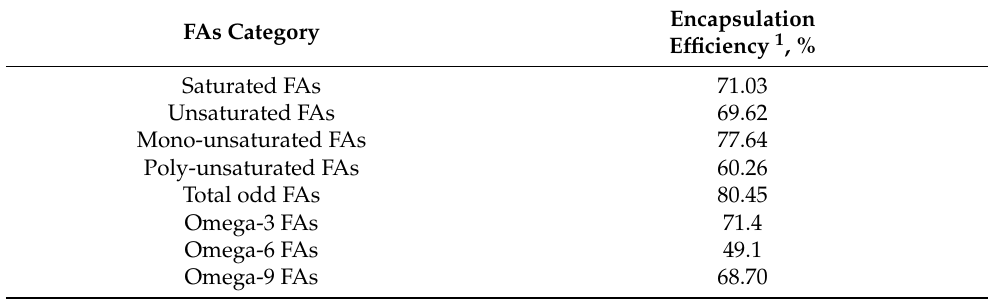
Table 2. Encapsulation efficiency of alginate-CaCL 2 for moringa extract fatty acids